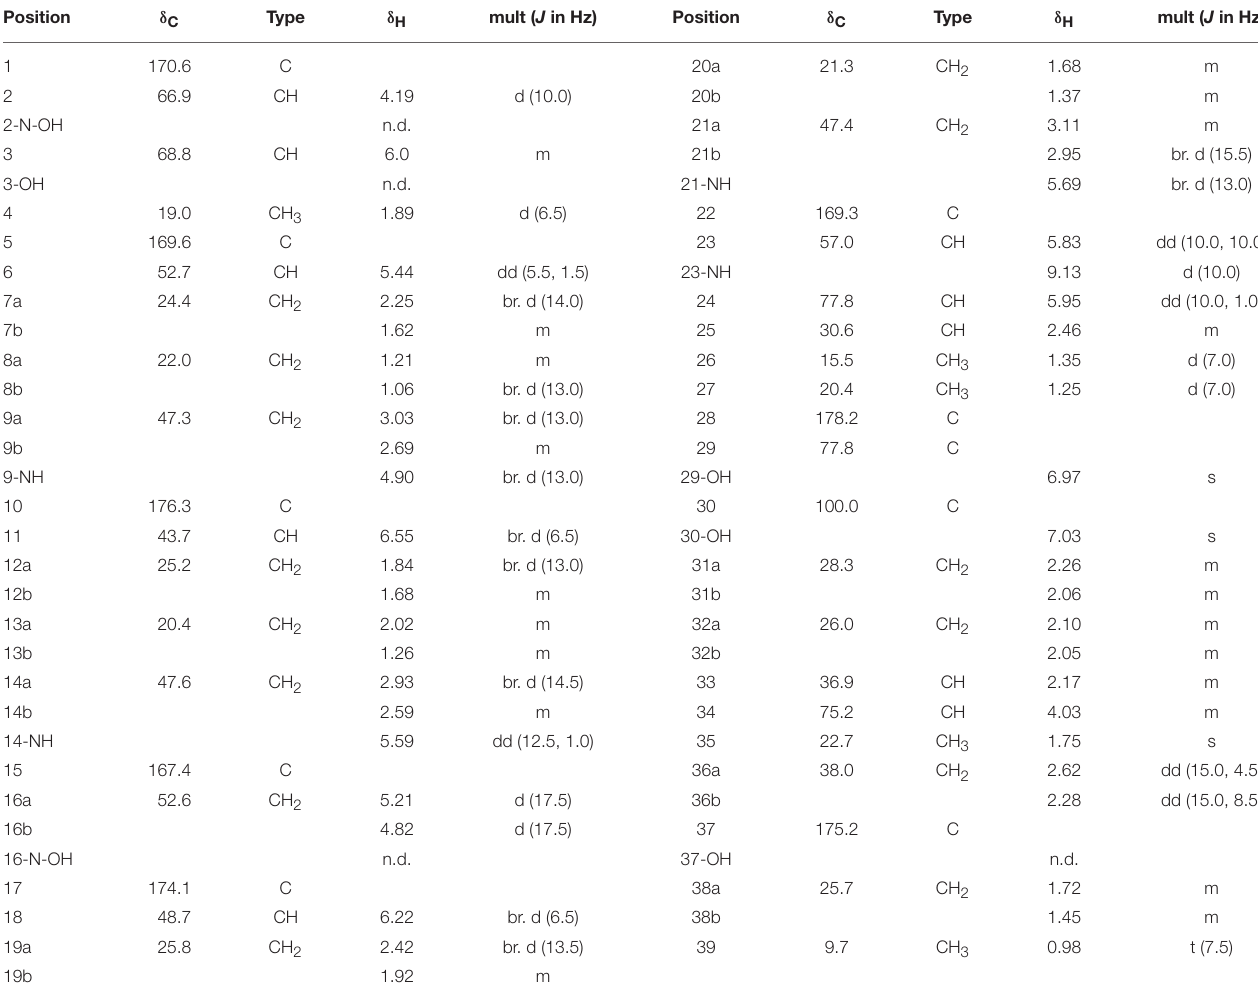
TABLE 1 | 1 H and 13 C NMR spectral data of dentigerumycin E ( 1 ) in pyridine- d 5 a .